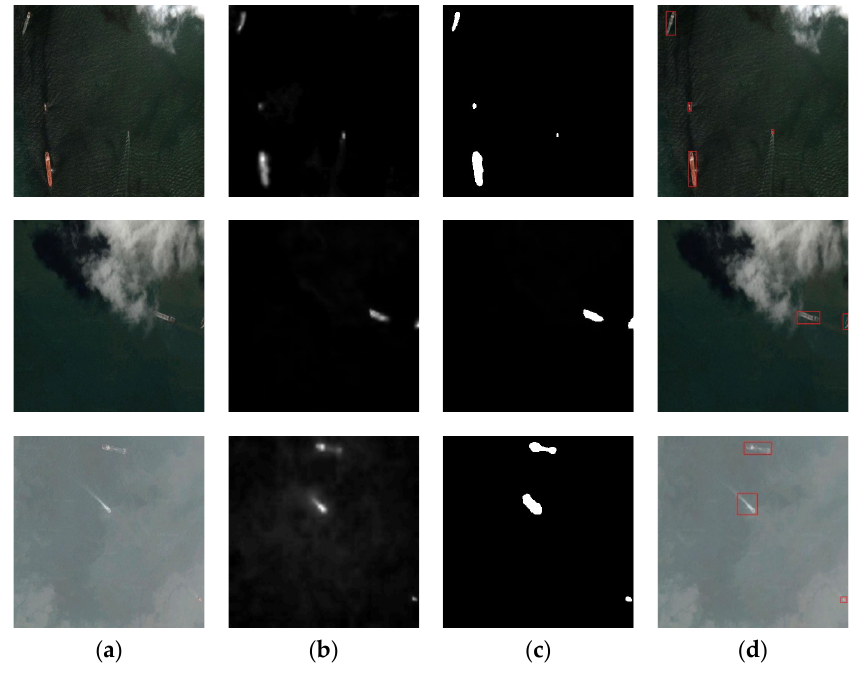
Figure 5. Results of the candidate region extraction. ( a ) The original image; ( b ) Saliency maps; ( c ) Binary graphs generated by adaptive threshold segmentation model; ( d ) The results of the candidate region extraction. With the practical operation of the algorithm, the false alarm can be reduced as much as possible and the ship target can be displayed in the coarse detection stage.